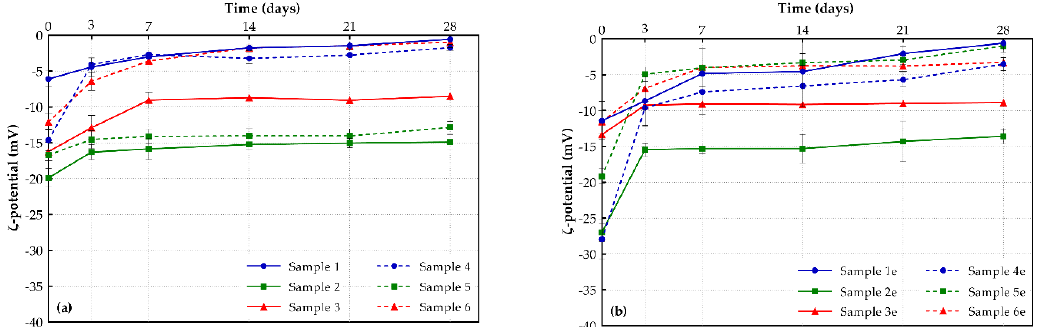
Figure 5. ζ-potential values of ( a ) drug-loaded and ( b ) drug-free liposomal formulations (storage conditions: 4°C, 28 days).